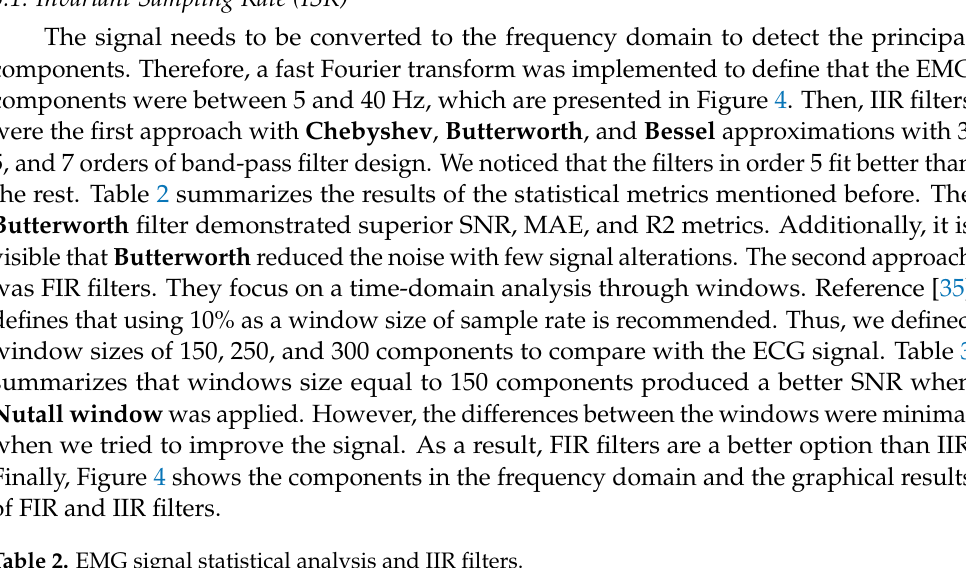
Table 2. EMG signal statistical analysis and IIR filters.